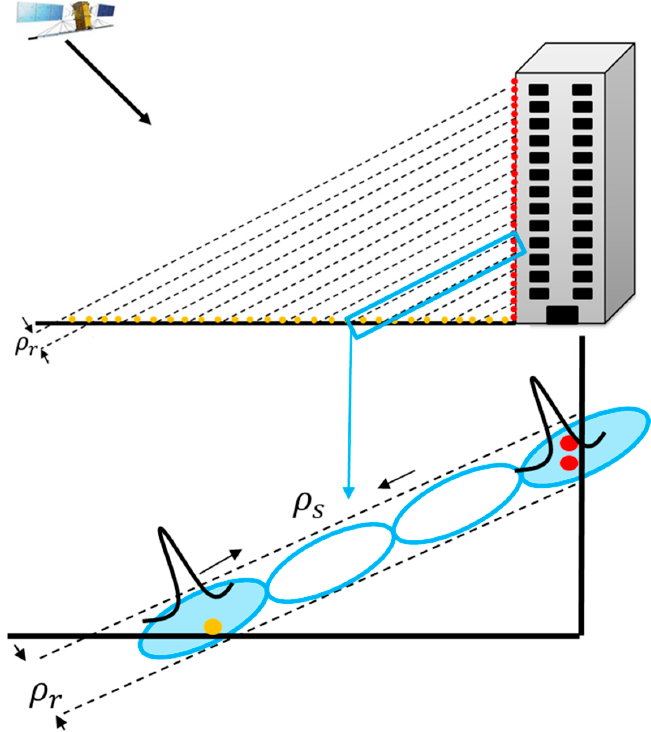
Figure 3. The elevation resolution in an azimuth-range cell.